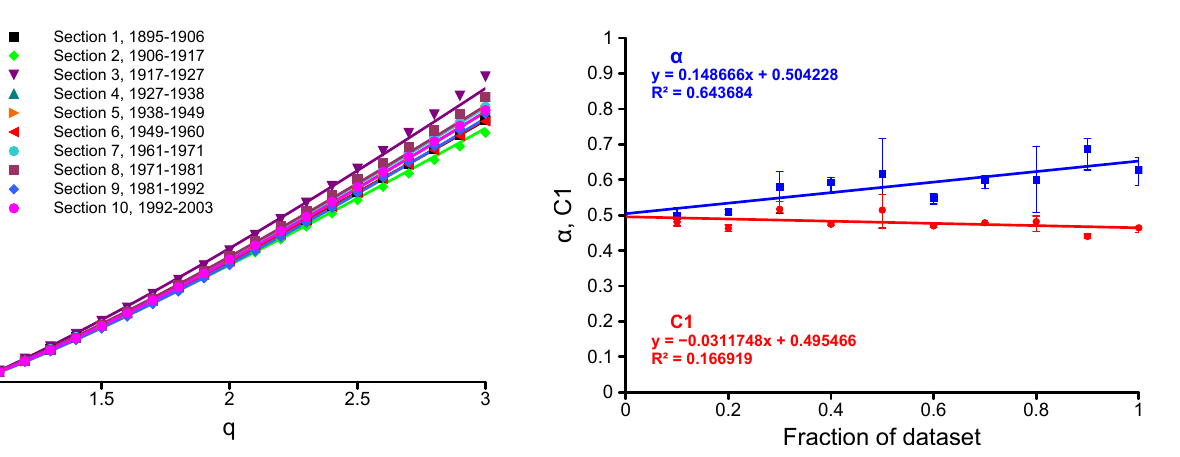
Fig. 4b. Variation in values of α and C1 by fraction of the Medicine Hat snowfall. Each section corresponds to one-tenth of the entire time series. The vertical bars represent the maximum and minimum α and C1 values computed over each interval. Temporal variability of multifractality of Medicine Hat daily snowfall data, 1895–2003. Each section corresponds to one-tenth of the entire time series.